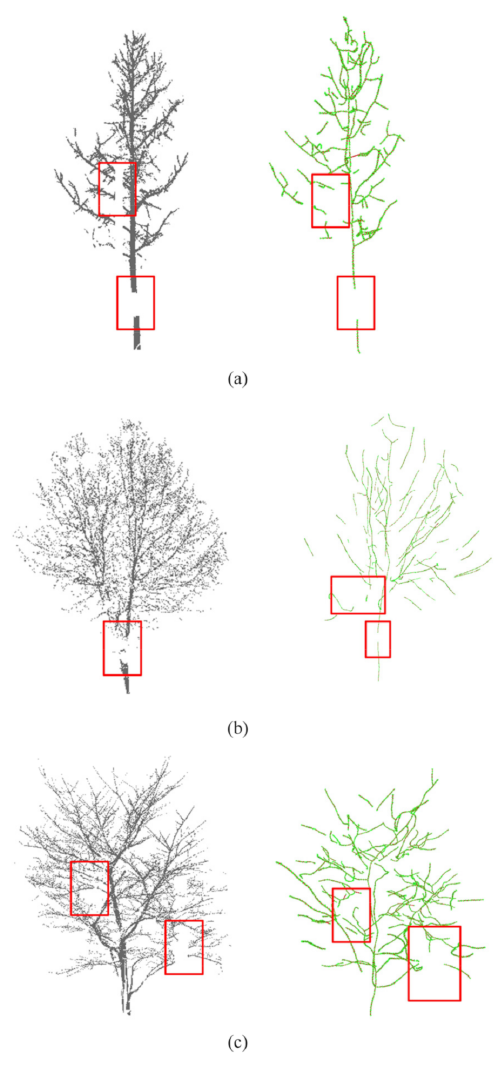
Figure 6. The initial skeleton points extracted by L 1 -Median algorithm. ( a ) Ginkgo biloba ; ( b ) Platanus acerifolia ; ( c ) Cerasus serrulate . The left column is the original point cloud, the right column is the initial skeleton structure. The red frame is the incomplete point cloud caused by the blocking of street lights and vehicles, the red dots are the skeleton points, and the green lines are the skeleton